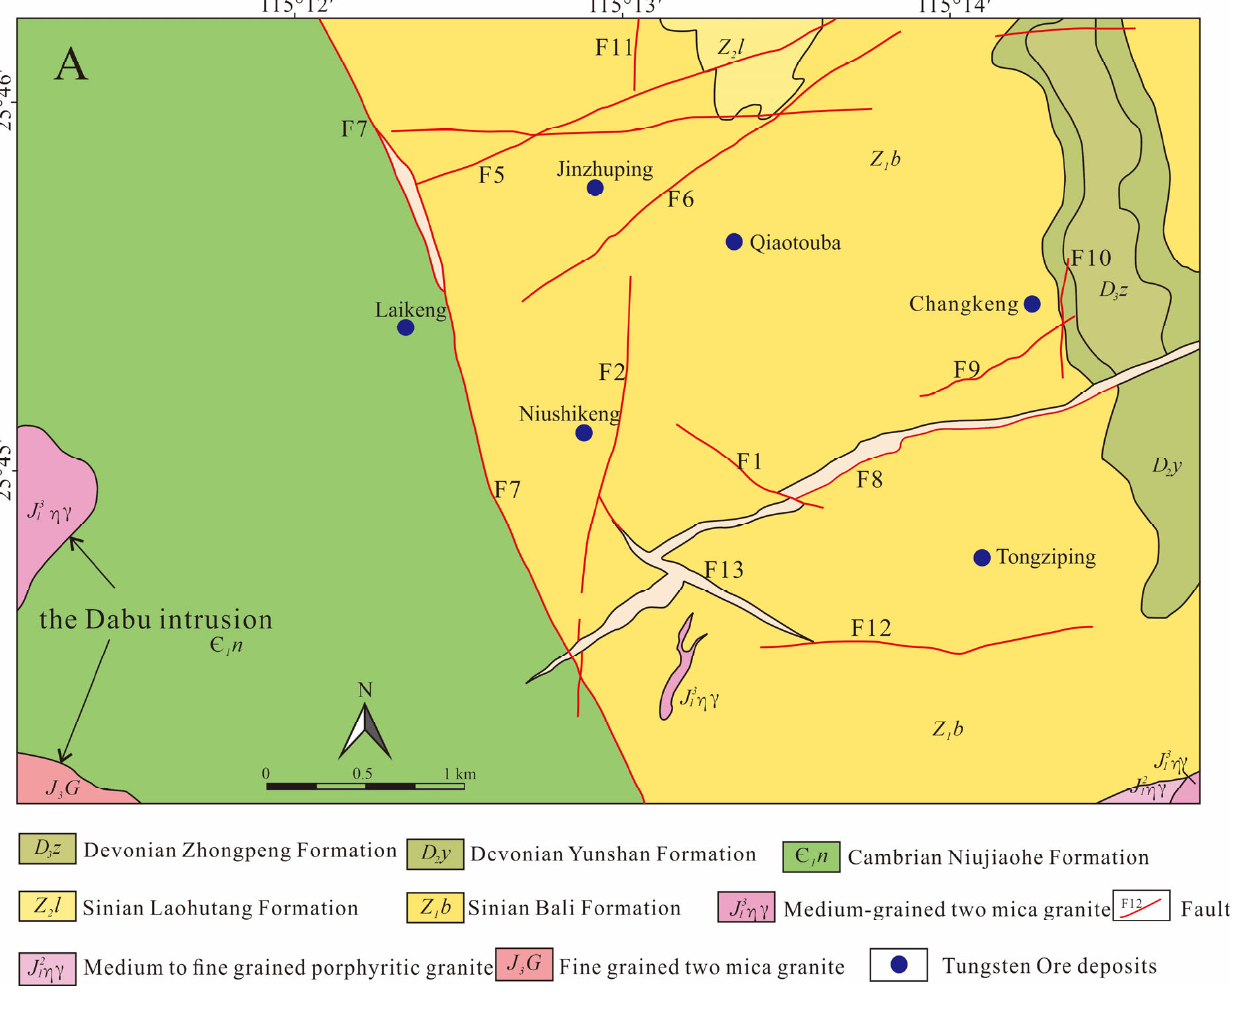
Figure 2. Geological map of the Helong ore field (modified from [5]).